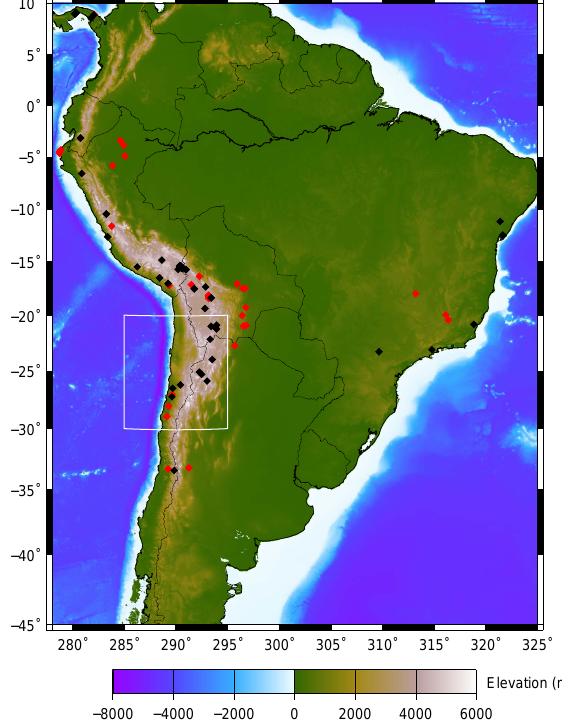
Figure 1. Map of South America including locations of borehole temperature measurements for heat flow stud- ies from the updated International Heat Flow Commis- sion (IHFC) (International Heat Flow Commission, 2011, http://www.datapages.com/gis-map-publishing-program/ gis-open-files/global-framework/global-heat-flow-database, last access: 19 June 2017) database. Red diamonds represent bore- holes deeper than 200m, while black is boreholes shallower than 200m. More than 100 bottom-hole temperature measurements, mainly in Brazil, are not included as they are not useful for climate studies. The rectangle indicates the study region of northern